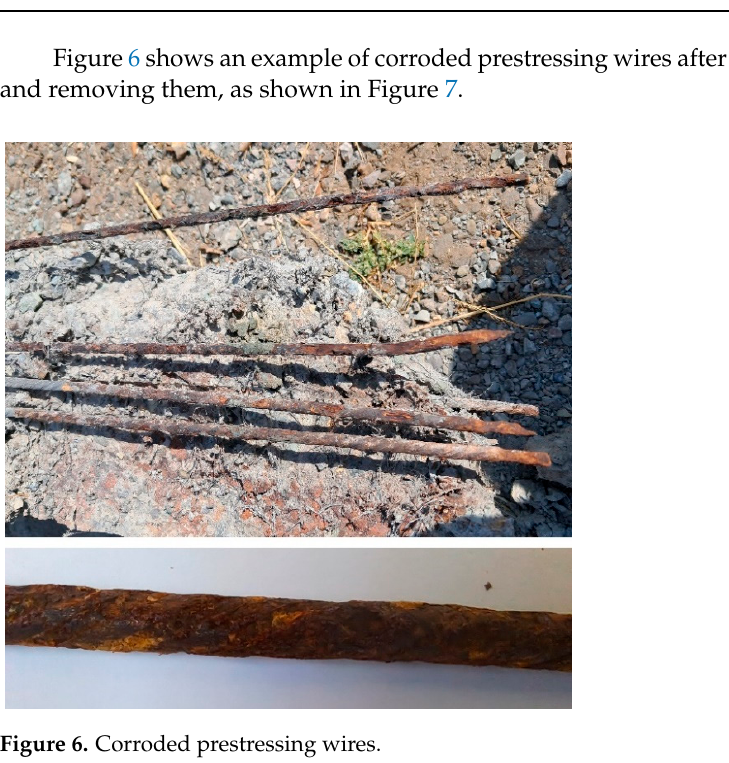
Figure 6. Corroded prestressing wires.